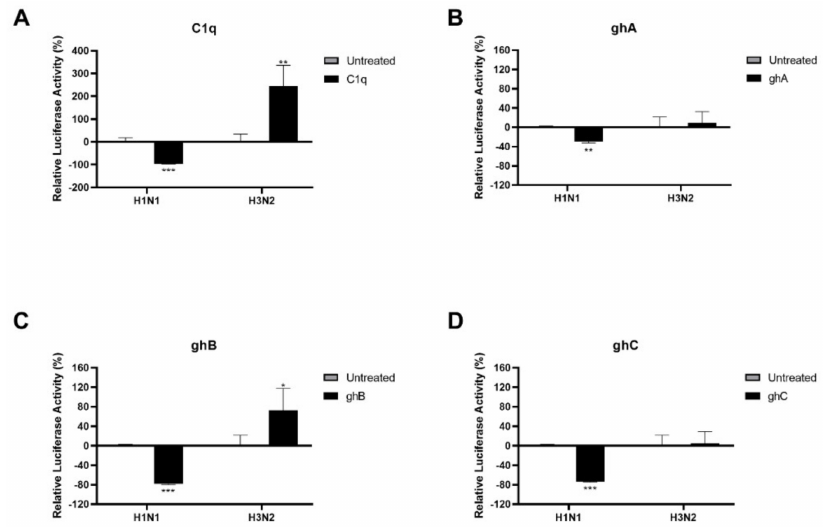
Figure 4. C1q, ghA, ghB, or ghC treatment modulates IAV entry in MDCK cells in a